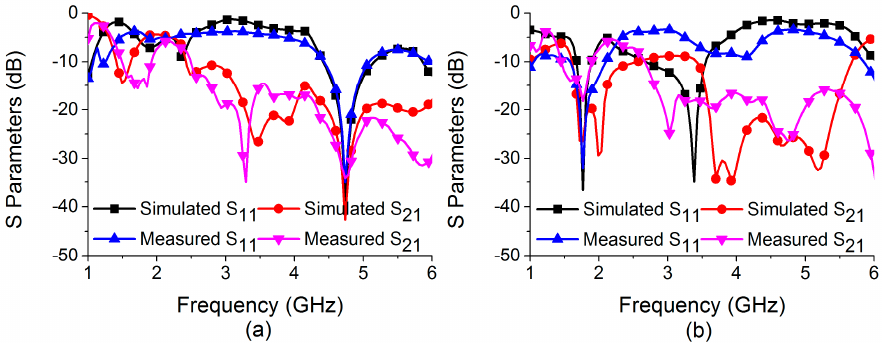
Figure 25. Simulated and measured S-parameters of the reconfigurable MIMO antenna in ( a ) ON state and ( b ) OFF state.